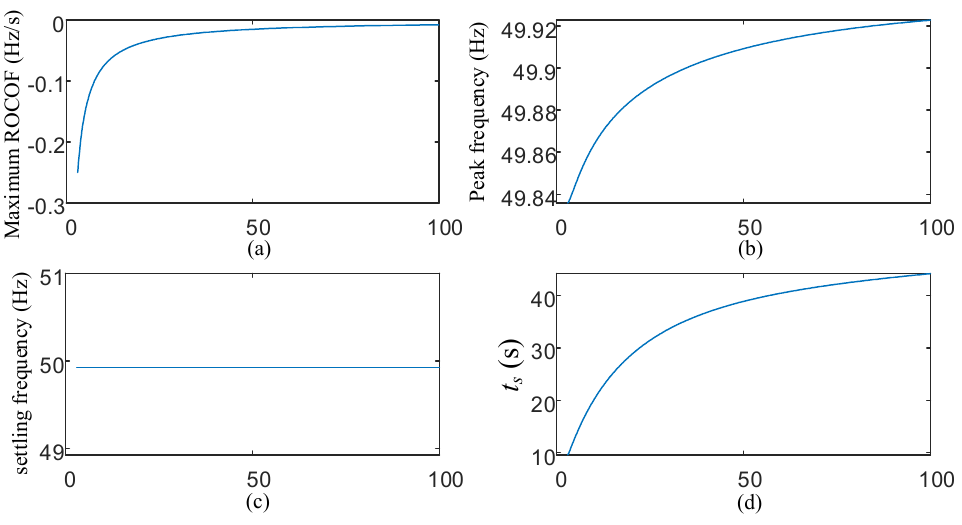
Figure 4. Inertia constant influence on performance indices: ( a ) maximum ROCOF, ( b ) peak frequency, ( c ) settling frequency, and ( d ) settling time.